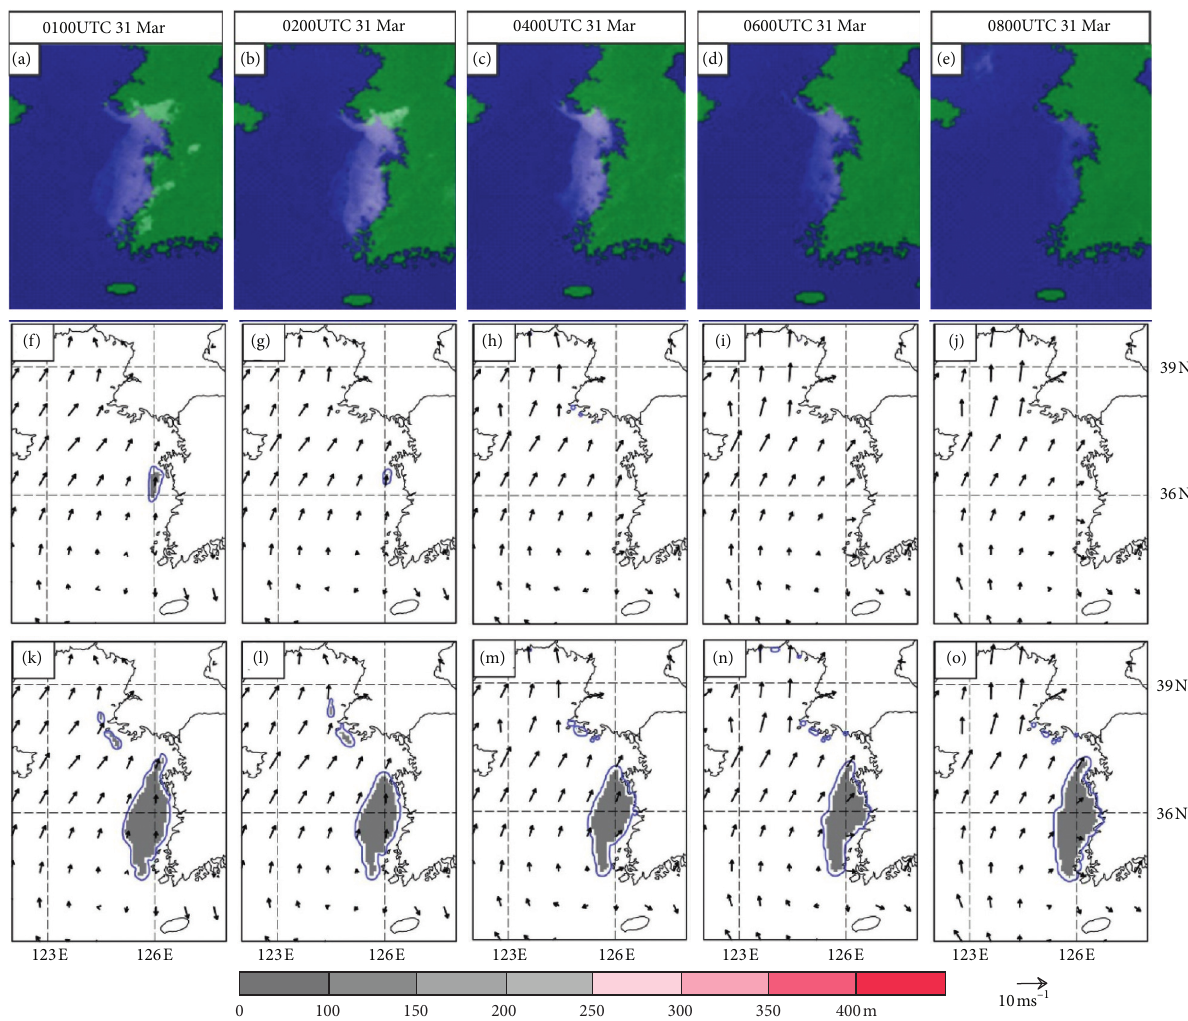
Figure 7: Comparison between the forecasted and observed sea fog areas (upper row; MTSATvisible imageries) for Case-A. The middle and lower rows show the results of Exp-A_CV5 and Exp-A_CV6, respectively. Fog depth is shown by shadings, and surface winds are displayed by